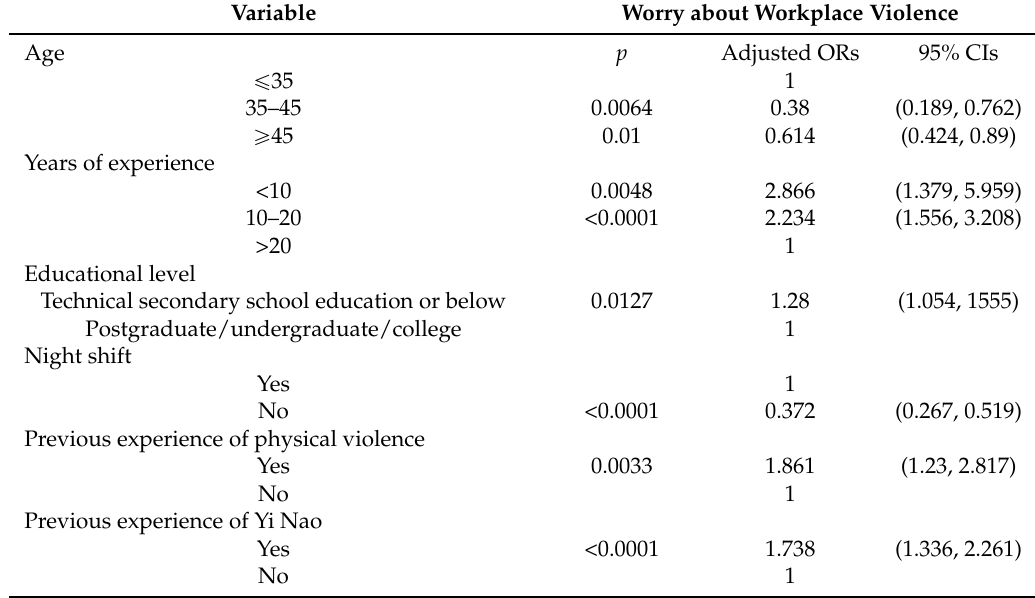
Table 5. Ordinal regression results on the risk factors contributing to worry about workplace